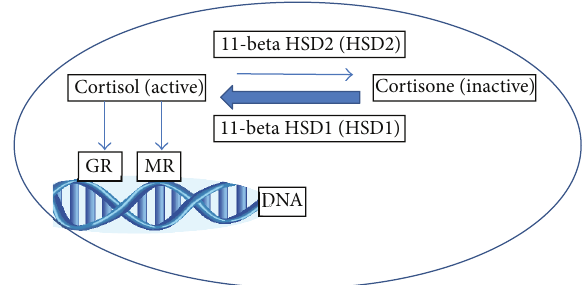
Figure 1: Adipocytes do not have significant HSD2 activity and yet maintain a relatively high level of HSD1 activity, allowing for increased intracellular active cortisol relative to inactive cortisone. Cortisol exerts its effects in adipocytes by binding to both gluco- corticoid receptor (GR) and mineralocorticoid receptor (MR) with similarly high affinity. Obesity has been associated with increased adipose HSD1 activity, further increasing intra-adipocyte cortisol